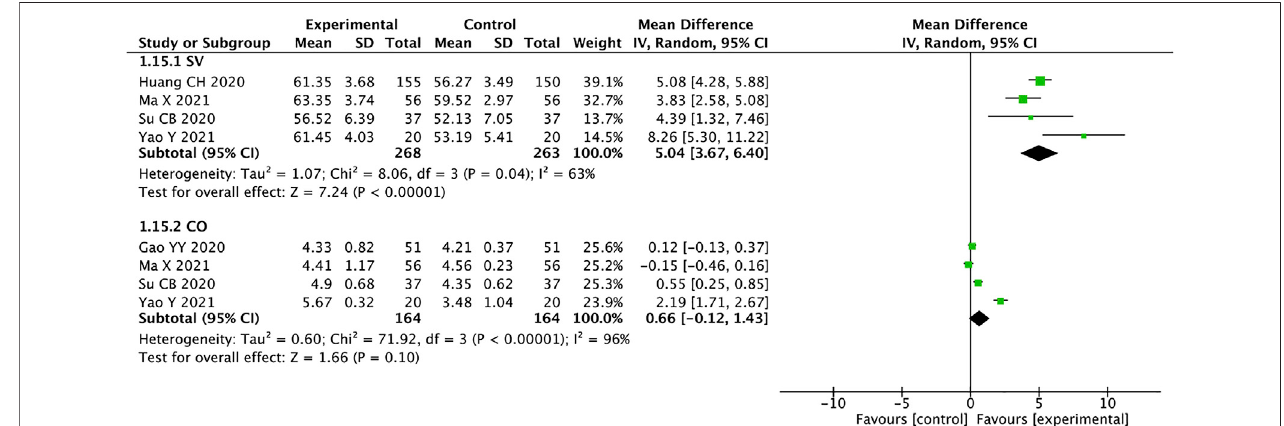
FIGURE 10 | Forest plot of SV and CO.